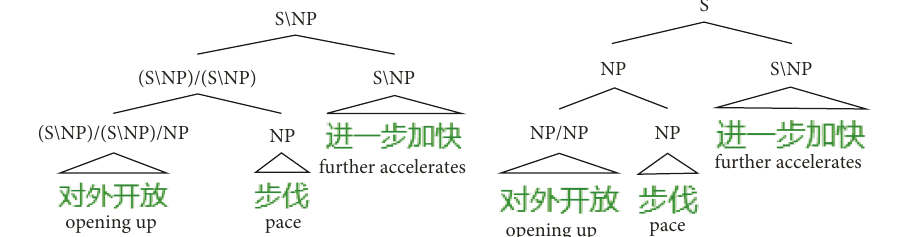
Figure 14: Coordination.